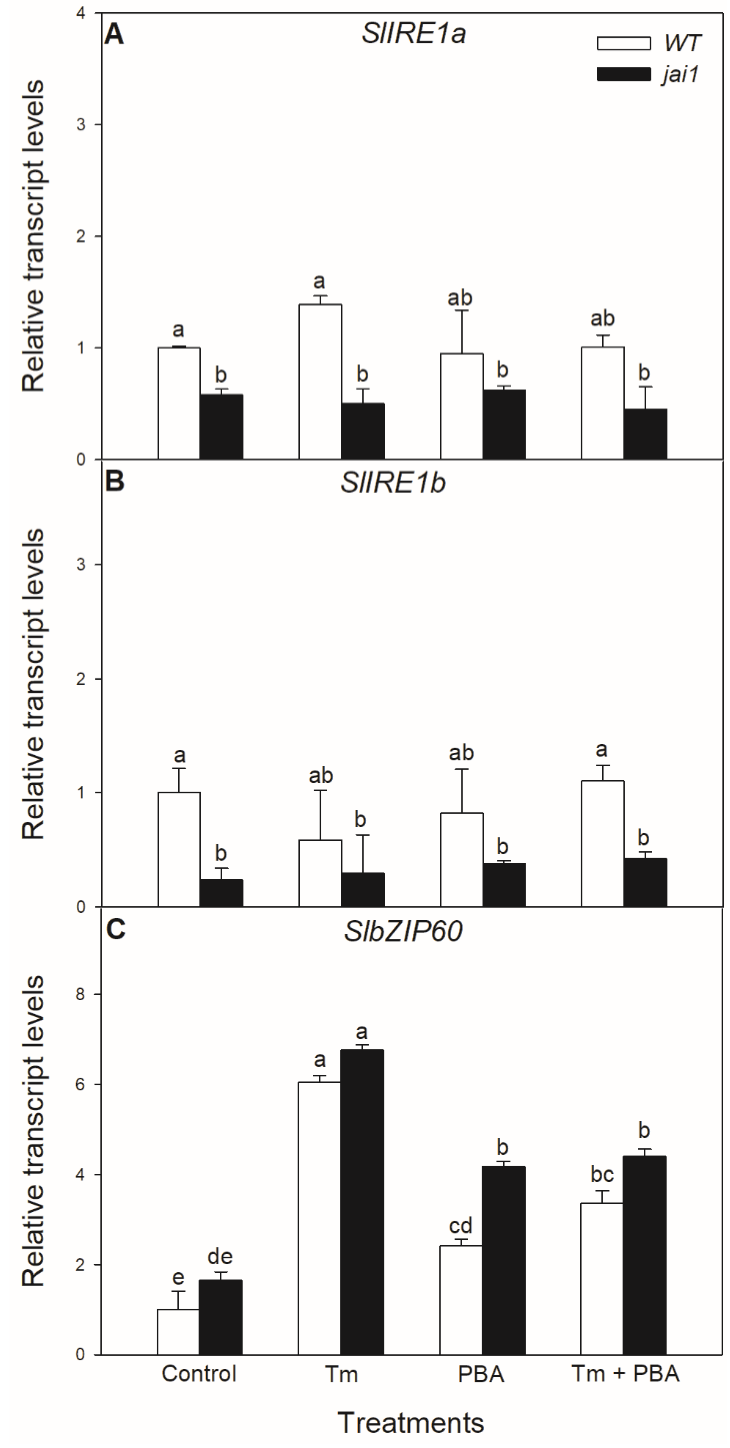
Figure 5. Changes in the transcript accumulation of SlIRE1a ( A ), SlIRE1b ( B ) and SlbZIP60 ( C ) in the leaves of wild-type (WT) and JA signalling mutant (jai1) tomato plants exposed to 5 µ g mL − 1 tunicamycin (Tm), 1 mM 4-phenylbutyrate (PBA), and Tm + PBA for 6 h. Results are the means ± SE. Data with di ff erent letters indicate significant di ff erences at p < 0.05 level, n =